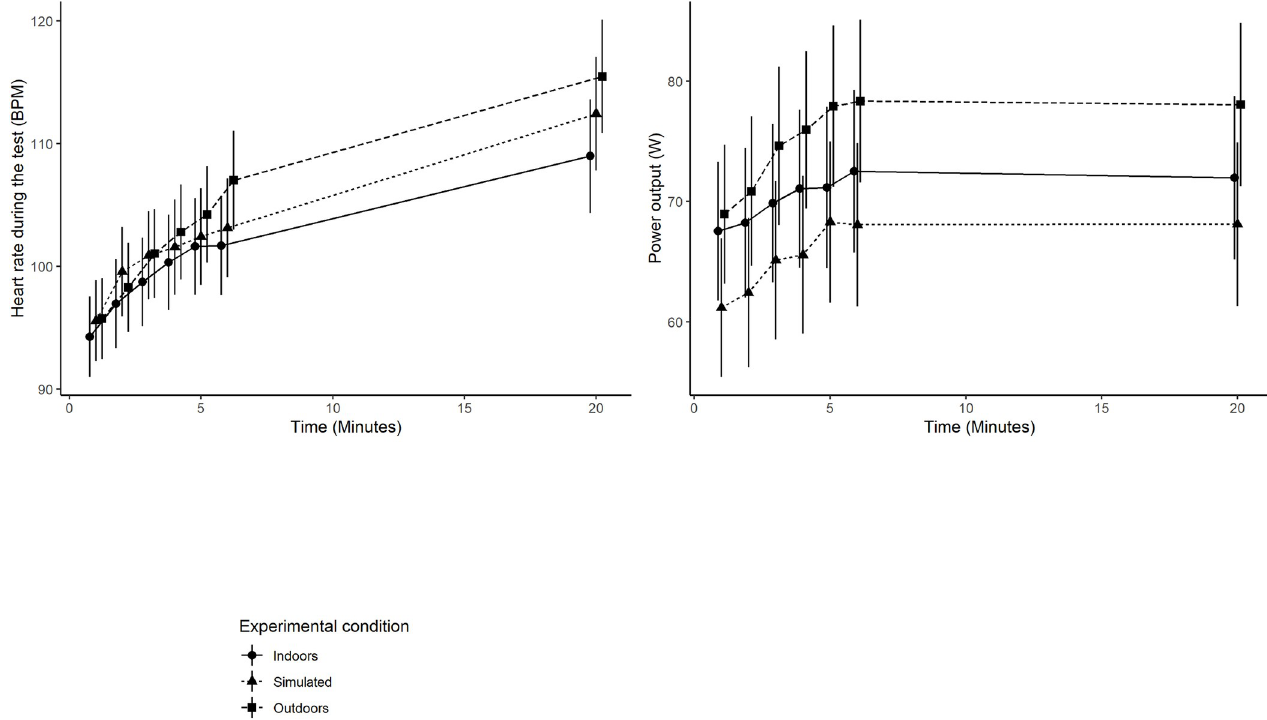
Fig 4. The crude mean values and the associated 95% CI for each measurement point in the different environments for heart rate and power output.